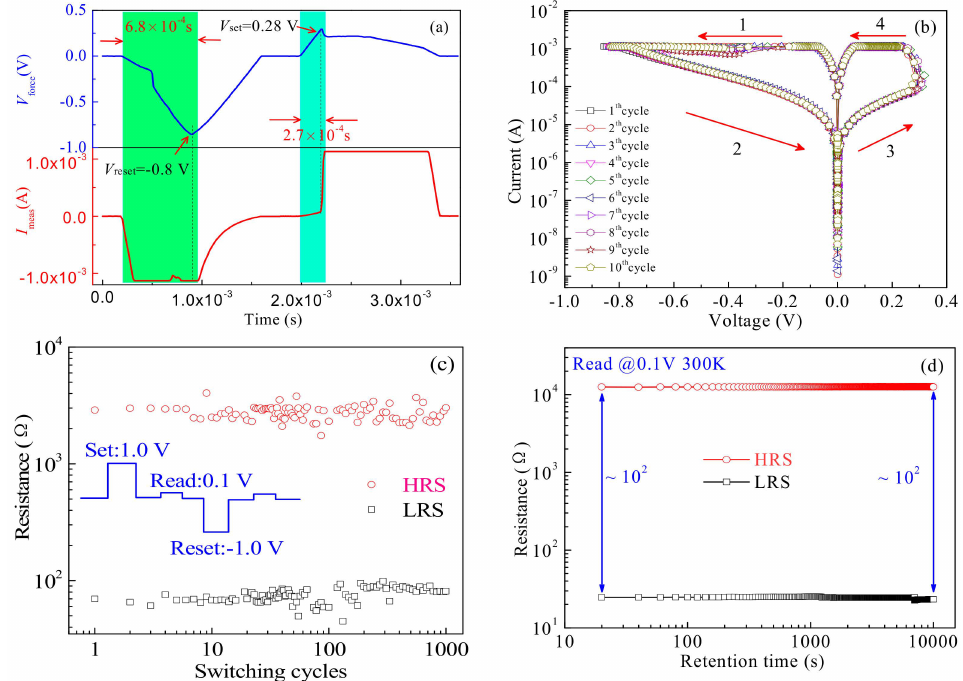
Figure 6. ( a ) The transient pulse characteristics of the device-C, the transition duration of set and reset processes is highlighted with greenish and bluish blocks, respectively; ( b )The switching characteristics of devices-C at a pulse voltage, the pulse with a reset voltage of − 1.0 V, a set pulse of 1.0 V, a width time of 1 × 10 − 6 s, rise time of 7 × 10 − 4 s and delay time of 2 × 10 − 4 s; ( c ) Endurance performance of devices-C; ( d ) Retention performance, indicating stable HRS and LRS up to 10 4